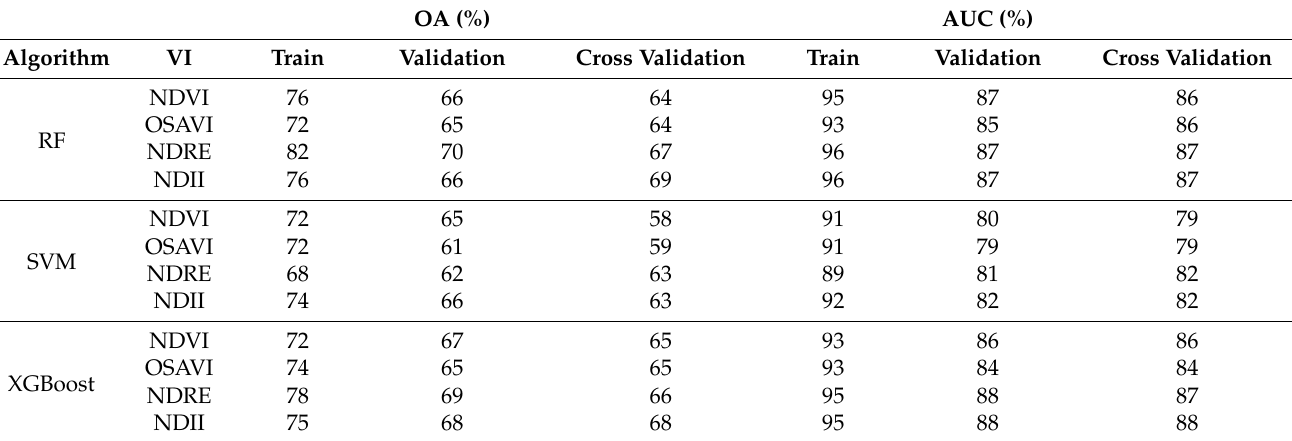
Table 2. OA and AUC results of the different classification methods.